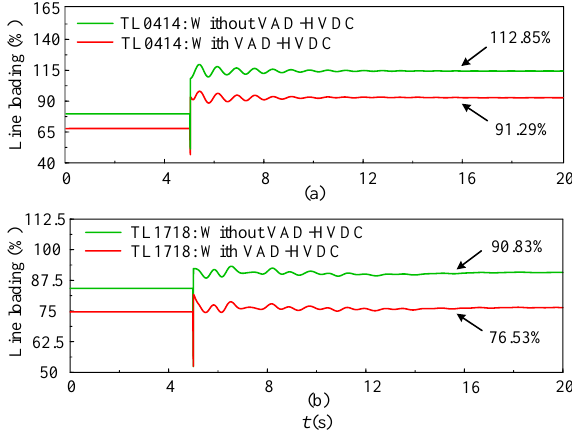
Fig. 8 Critical loadings when TL0405 is disconnected: (a) line loading of TL0414; (b) line loading of